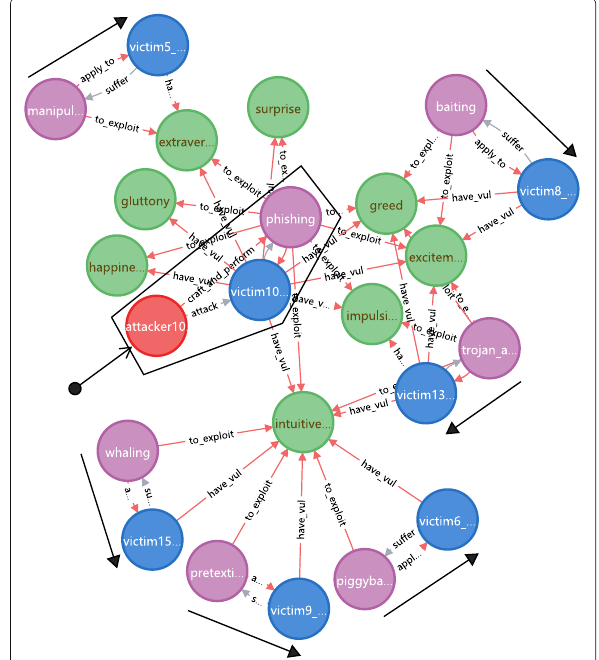
Fig. 24 For specific attacker, find potential targets (victims) beyond the given scenario